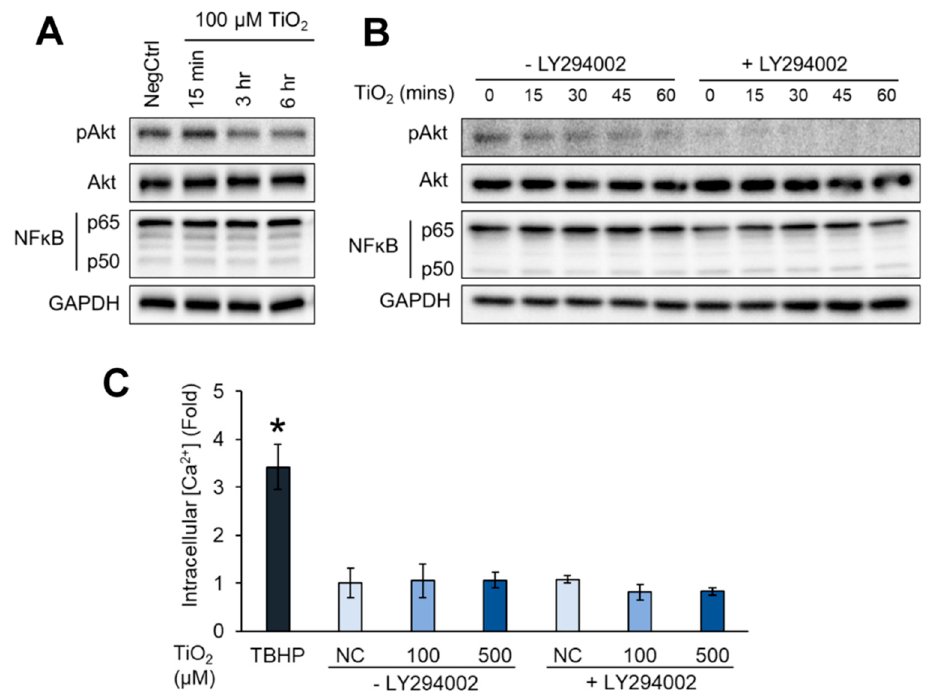
Figure 4. TiO 2 NPs down-regulated the protein kinase B (Akt) pathway as a late event of endothelial leakiness. ( A ) HHSECs exposed to 100 µM TiO 2 NPs for 3 and 6 h showed a reduction in phosphorylated Akt. GAPDH was used as a loading control. ( B ) Reduction of phosphorylated Akt showed a time-dependent response upon exposure to 100 µM TiO 2 NPs up to 1 h. Akt inhibitor (LY294002) was reduced as a positive control to inhibit Akt phosphorylation. ( C ) TiO 2 NPs did not induce intracellular calcium ion (Ca 2+ ) release after 3 h exposure. TBHP was used as a positive control. Data represent mean ± SE ( n = 3), * p < 0.05.